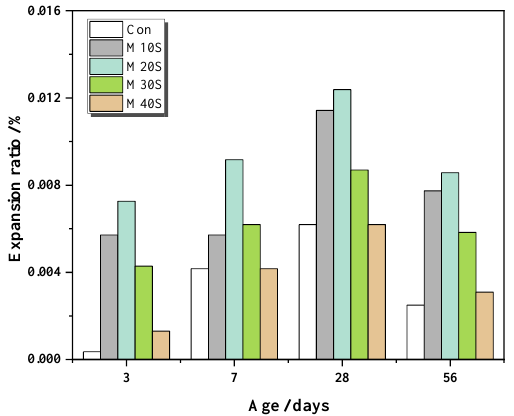
Figure 8. Expansion ratio of mortar specimens.